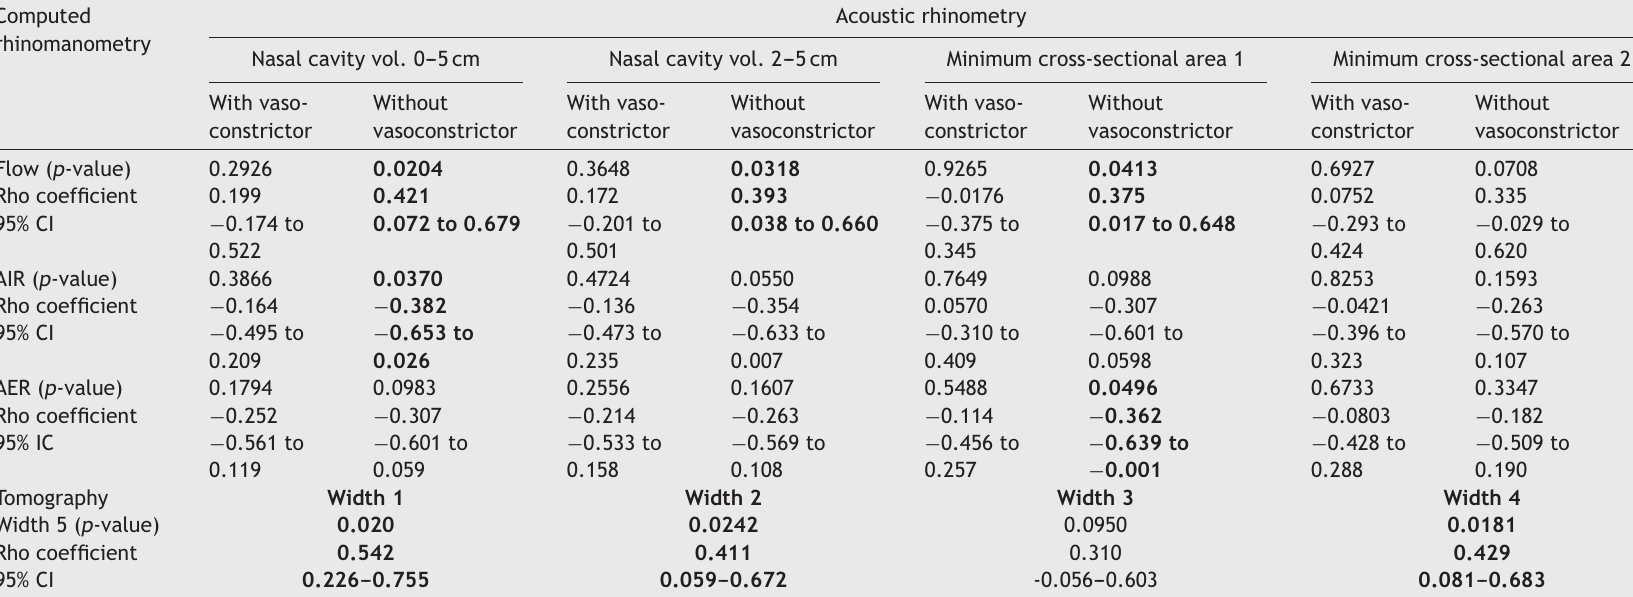
Correlation between data of acoustic rhinometry and computed rhinomanometry in mouth breathers with transverse maxillary deficiency, as well as between width 5 and width 1 to 4 of cone- beam computed tomography of maxilla and nasal